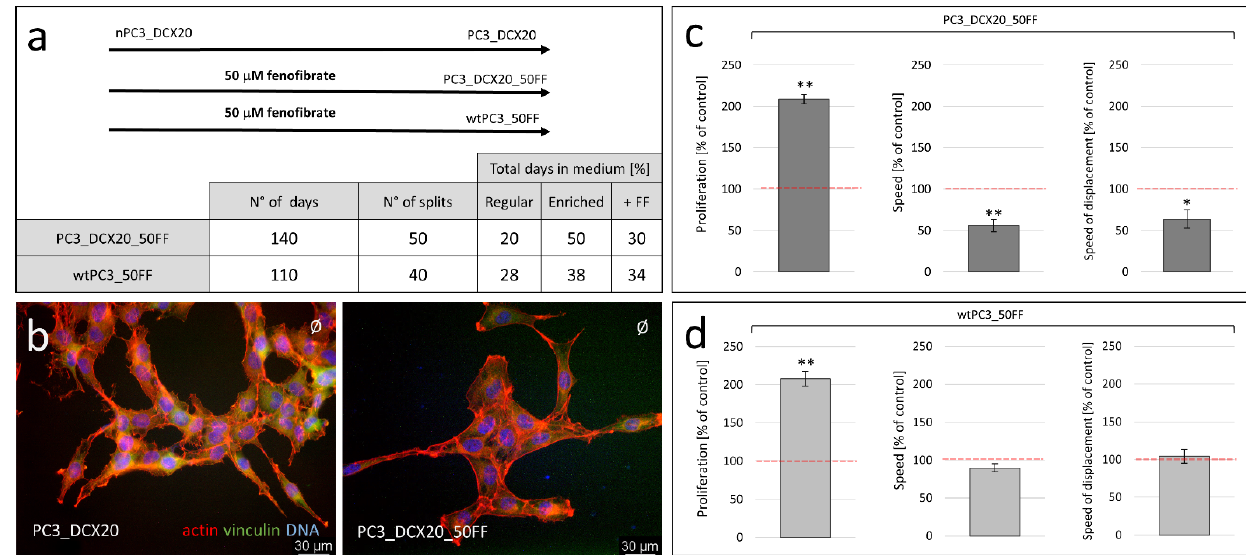
Figure 3. Fenofibrate-induced phenotypic microevolution of PC3 cells. ( a ) The scheme of the experimental approach for the establishment of FF-resistant PC3 progenies. ( b ) Morphology of PC3_DCX20 and PC3_DCX20_50FF cells estimated with immunofluorescence (F-actin/vinculin/DNA staining). ( c ) Proliferation and motility parameters of PC3_DCX20_50FF cells incubated in